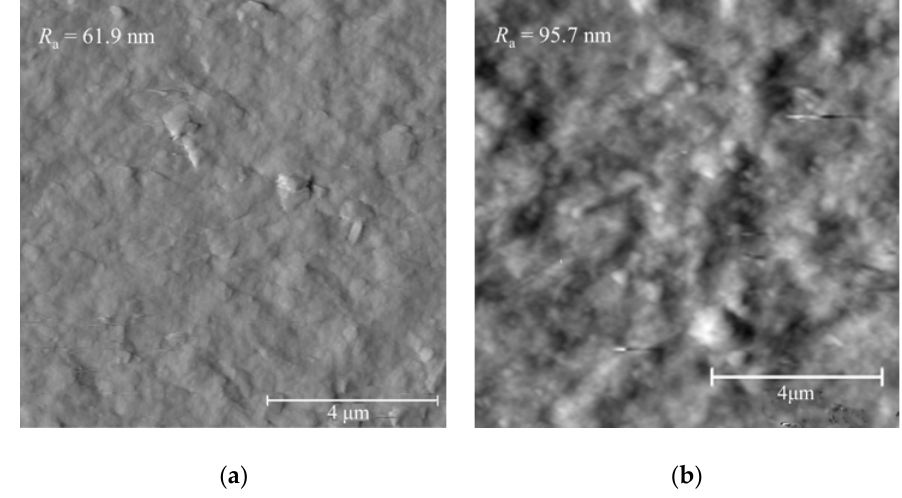
Figure 11. Surface roughness of ( a ) as-deposited and ( b ) annealed (at 600 °C) (ZrO 2 -MMT) 30 with clay montmorillonite 0.4 wt %.